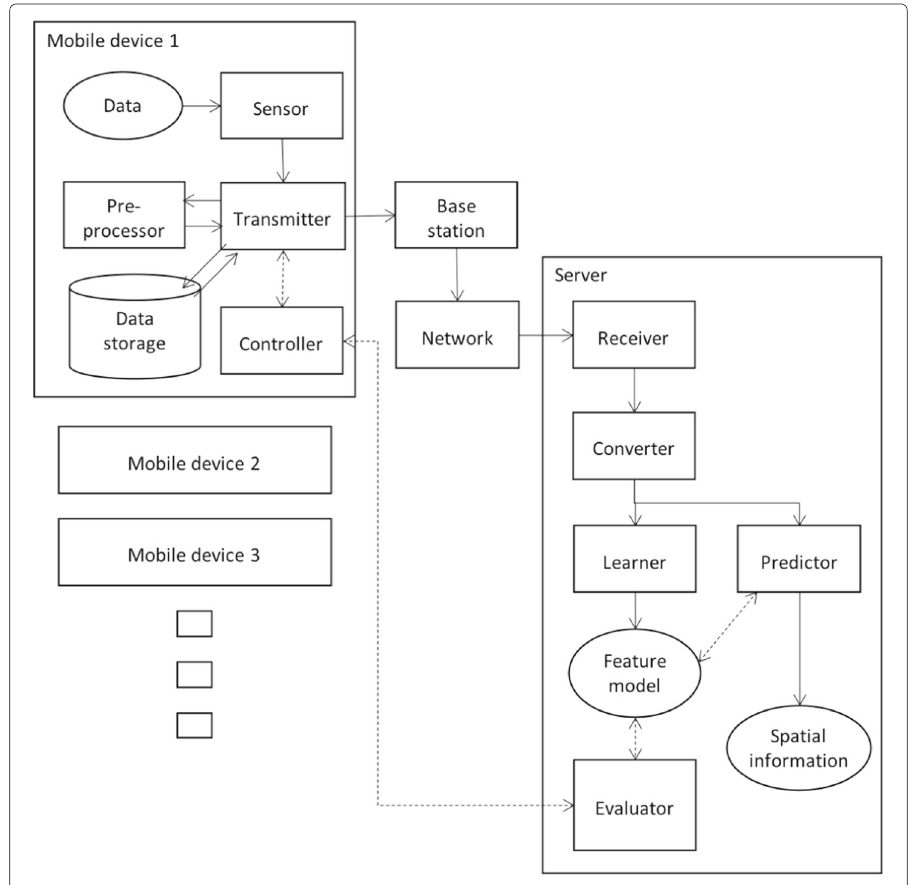
Fig. 2 Block diagram of proposed framework. Solid and broken lines indicate data flows and control messages, respectively